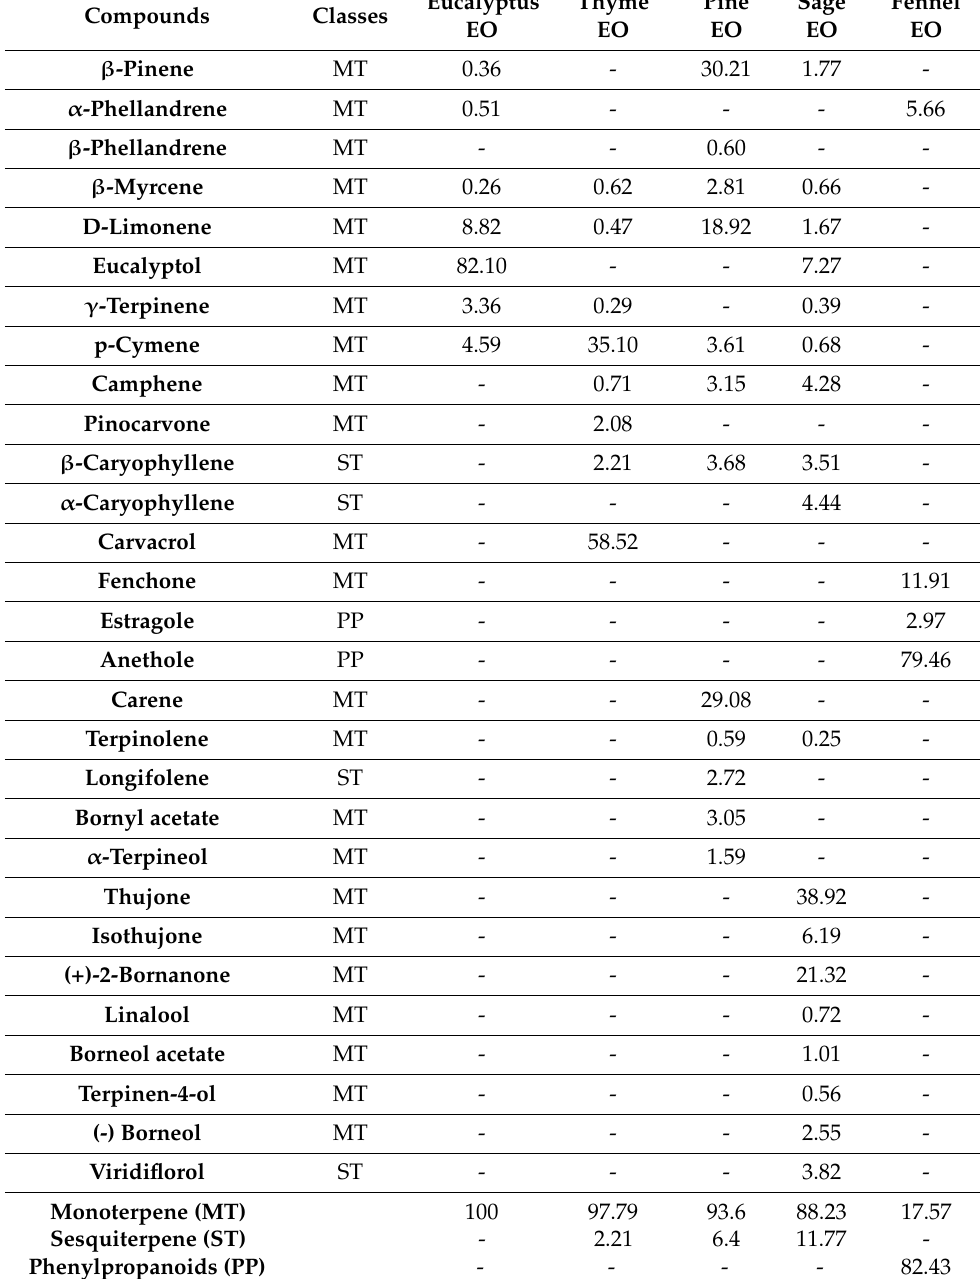
Table 4. Main constituents of investigated essential